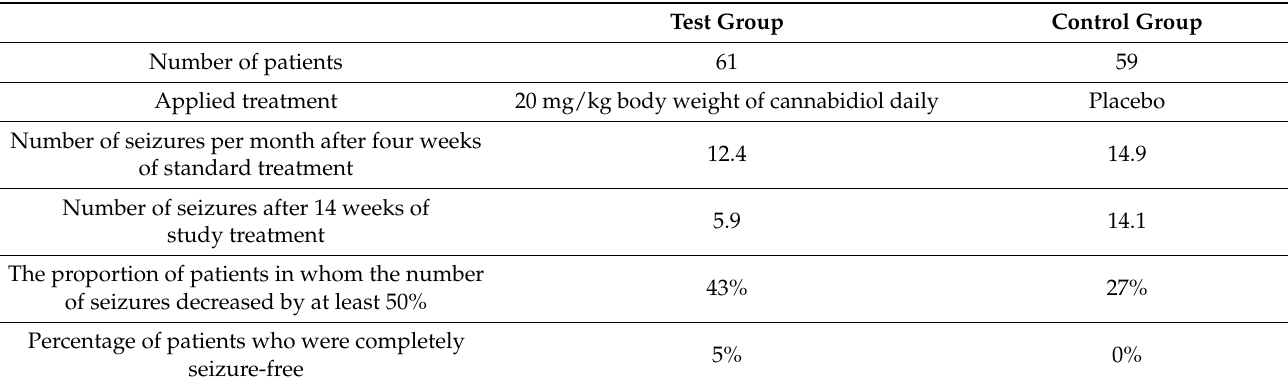
Table 4. Results of the efficacy of CBD in the treatment of epileptic seizures in Dravet’s syndrome in children [105]. Test Group Control Group Number of